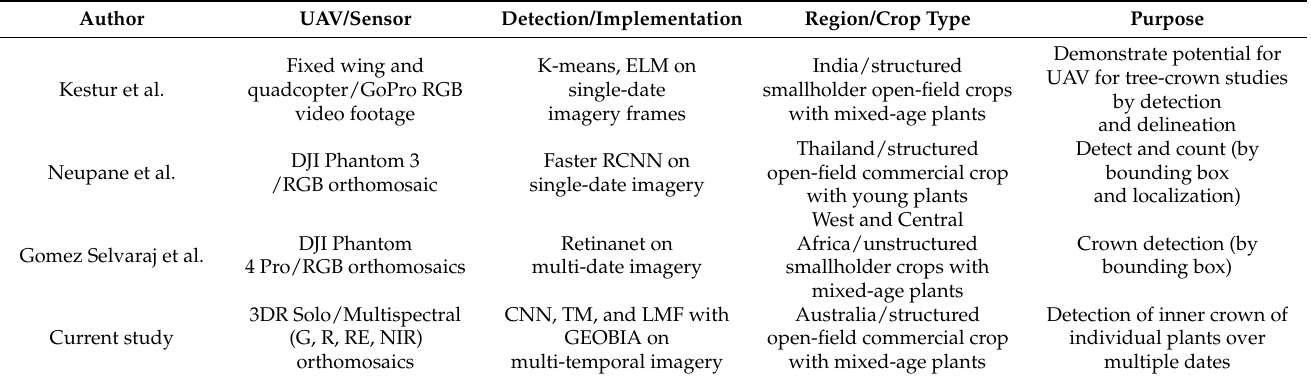
Table 1. Overview of existing studies on banana crown